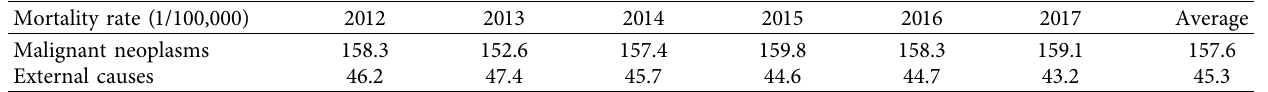
Table 6: The mortality rate of malignant neoplasms and external causes in China (1). Mortality rate (1/100,000) Malignant neoplasms External causes